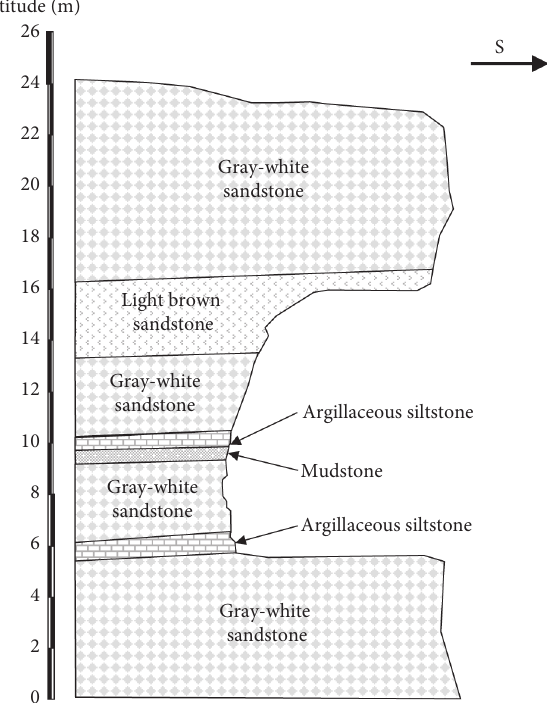
Figure 1: Typical geological section profile of the study area.